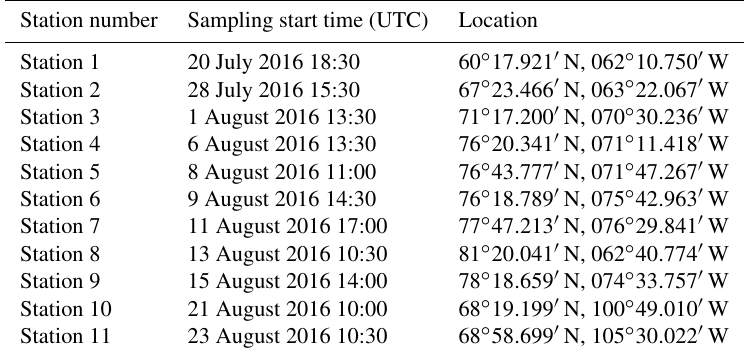
Table 1. Sampling times and geographic coordinates for the 11 stations